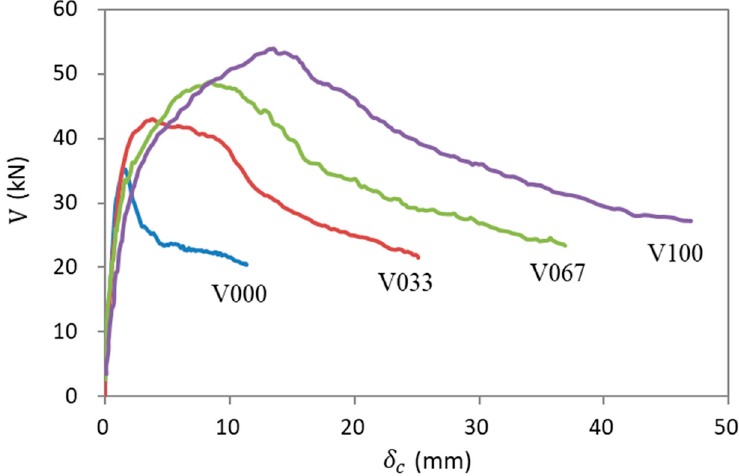
Figure 7. Typical load and displacement curves measured from the shear tests of anchors in the plain concrete and SFRC.